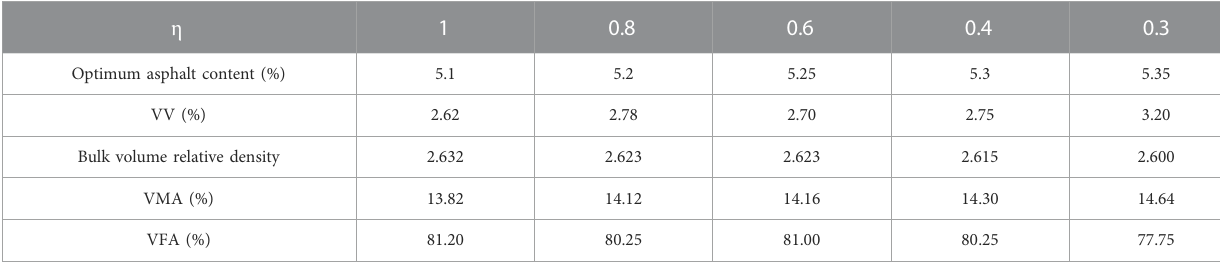
TABLE 6 olumetric parameters based on the minimum VMA.